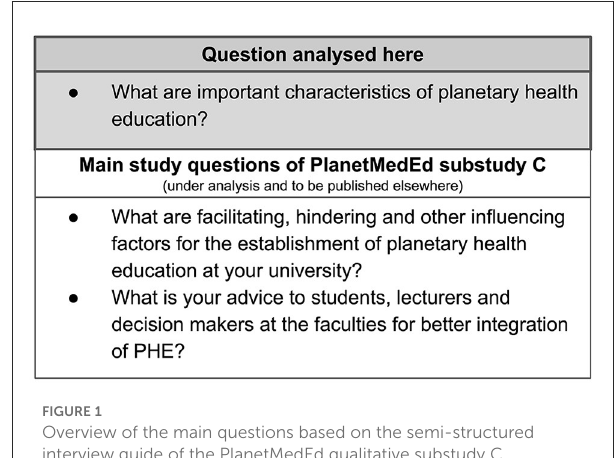
The process of inductively developing sub-categories